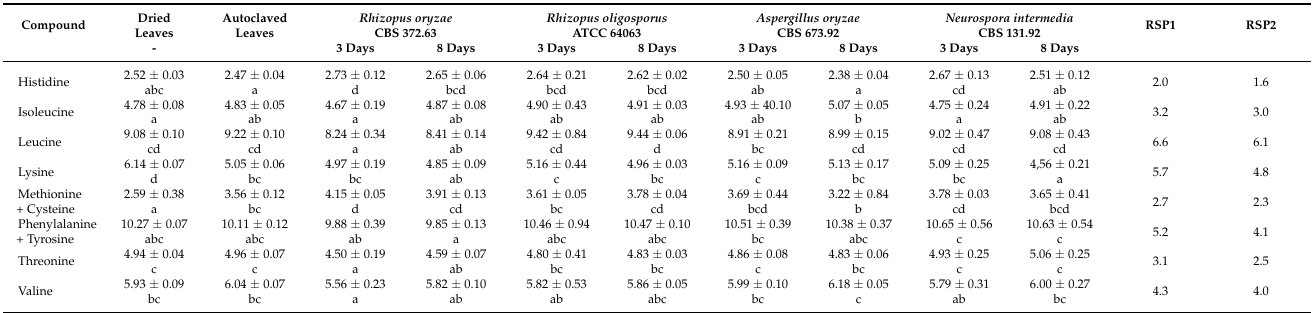
One-factor analysis of variance and Fisher post hoc test were applied. Data are shown as the mean ± SEM. Mean values within a row followed by different letters differ significantly ( p ≤ 0.05). Table 4. The quality of protein (g amino acid/100 g protein) of moringa leaves—dried, autoclaved, and fermented—with the studied microorganisms at each fermentation time point (3 and 8